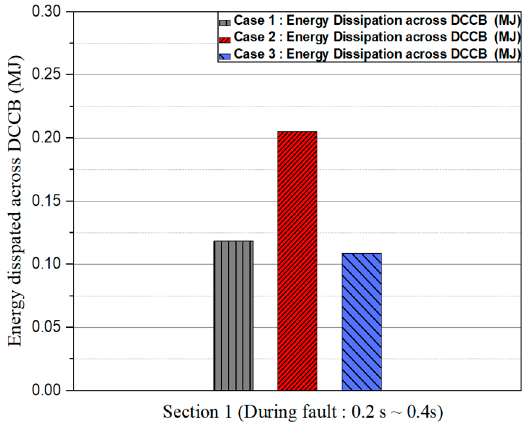
Figure 14. The comparison of energy dissipation across DCCB during fault period.